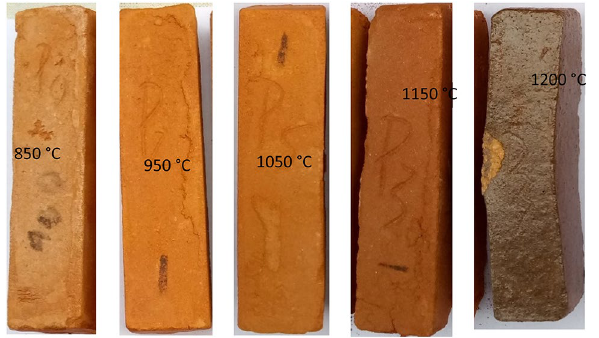
Fig. 5 Pictures of fired specimens